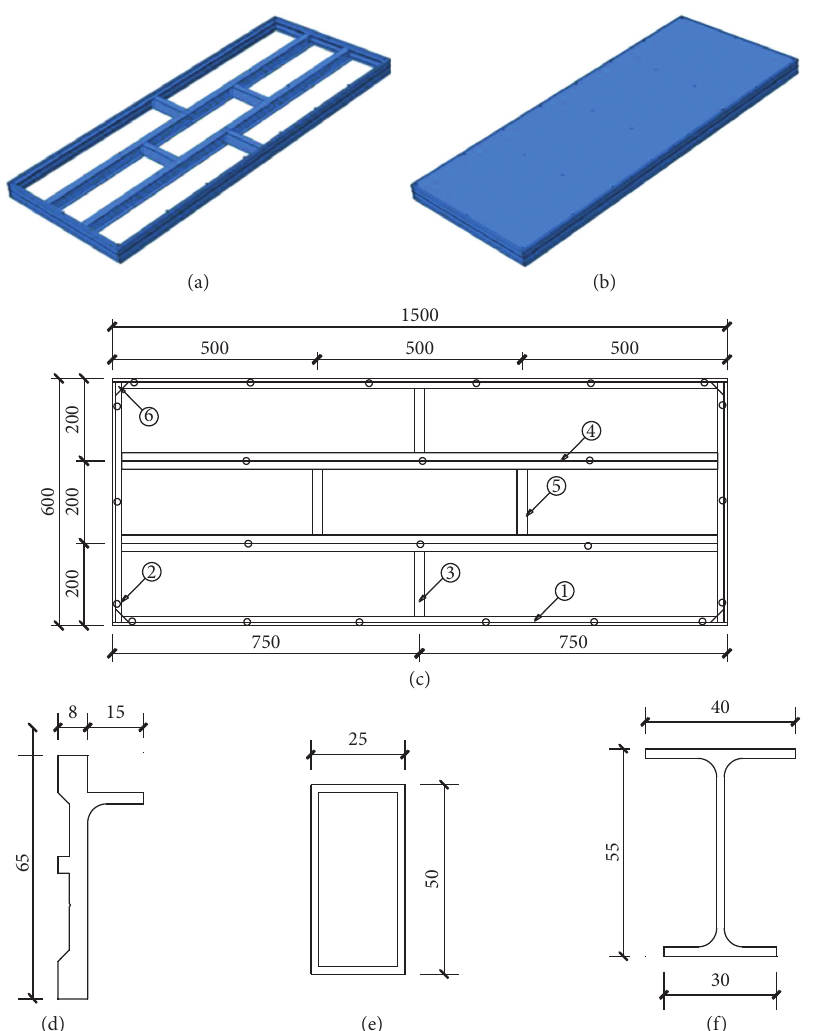
Figure 1: Geometric model of a single-span simply supported formwork (Type I). (a) Model of a frame without a template. (b) Model with a template. (c) Dimensions of the formwork. (d) Sections of ① and ② . (e) Sections of ③ and ⑤ . (f) Section of ④